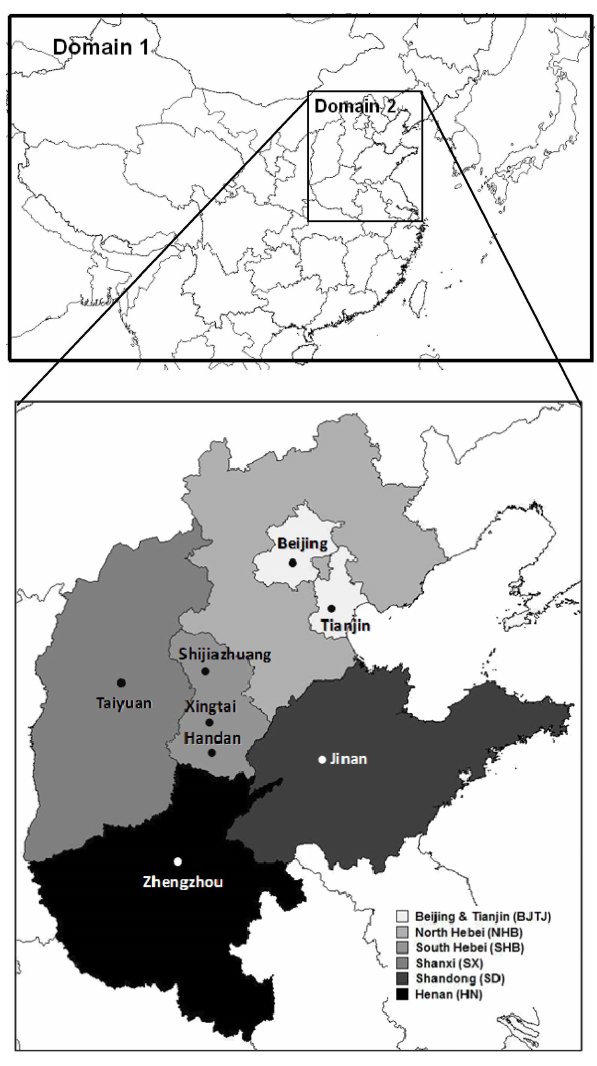
Fig. 1. CMAQ modeling domains at a horizontal grid resolution of 36km over East Asia (Domain 1 with 164 × 97 cells) and 12km over an area in northeastern China (Domain 2 with 93 × 111 cells). The zoom-in area (Domain 2) shows the regions focused in the analysis of source contributions. It includes six regions of interest: southern Hebei (which includes three cities: Shijiazhuang, Xingtai, and Handan), northern Hebei (which includes the remaining areas in the Hebei Province), Shanxi Province (SX), Shandong Province (SD), Henan Province (HN), and a two-city cluster region covering Beijing and Tianjin